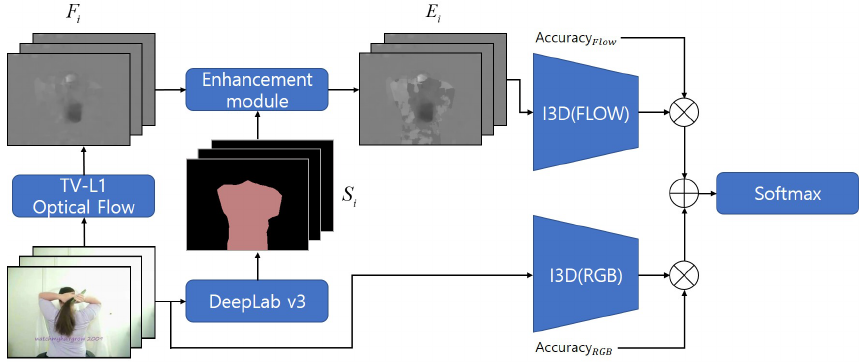
Figure 2. The overall architecture of proposed